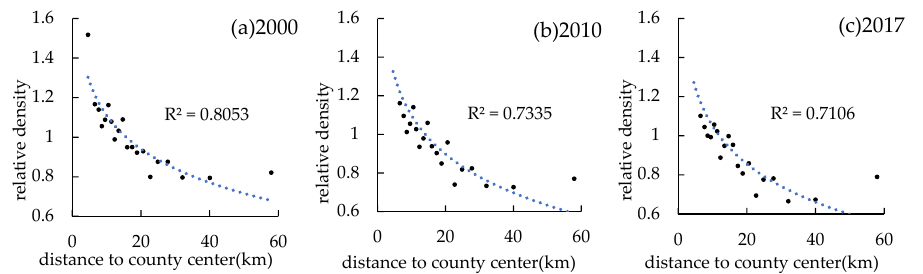
Figure 4. Binscatter diagram of the relative density of distance from each township unit to the administrative center of a county.